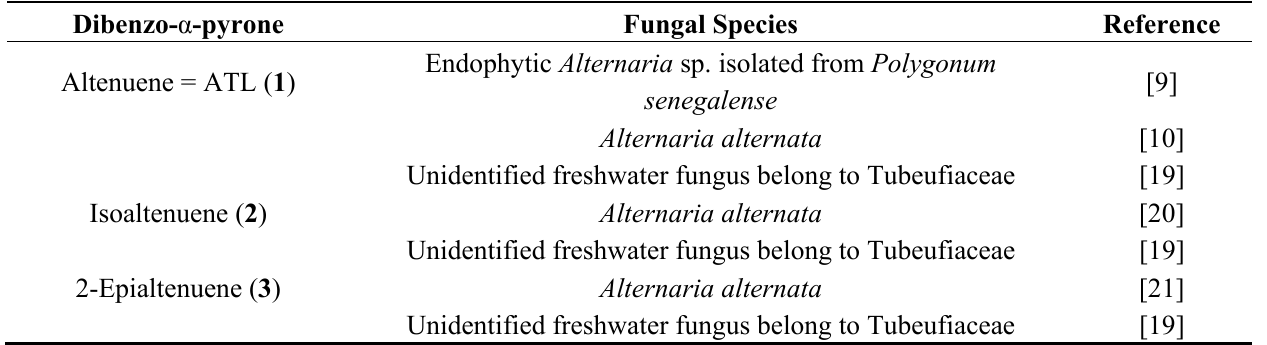
Table 1. Occurrence of the dibenzo- α -pyrones in